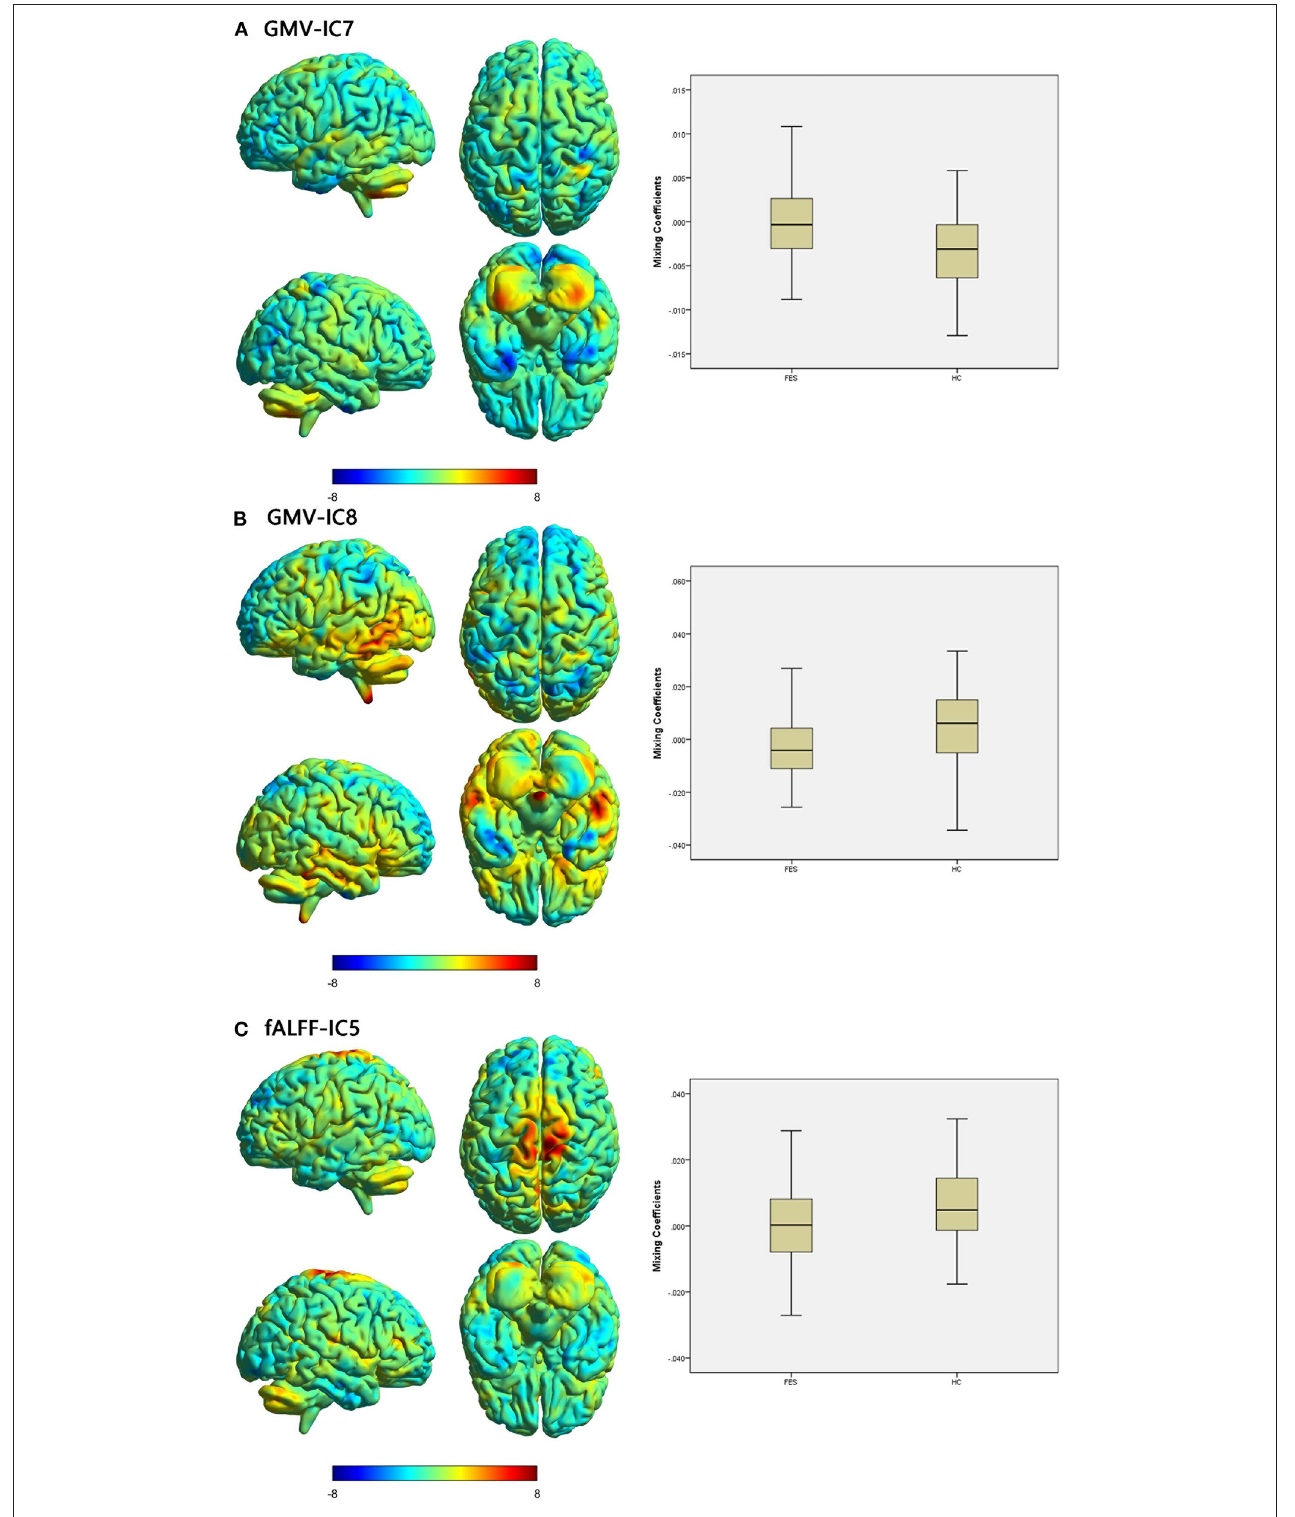
FIGURE 1 | Brain maps of discriminative IC and box plots of mixing coefficients between the FES and HC groups. The left part of the figure is the brain map, and the right part is the mixing coefficient box plot (outliers have been excluded). The color bar represents the Z-scores. Box plots show that the FES group has higher